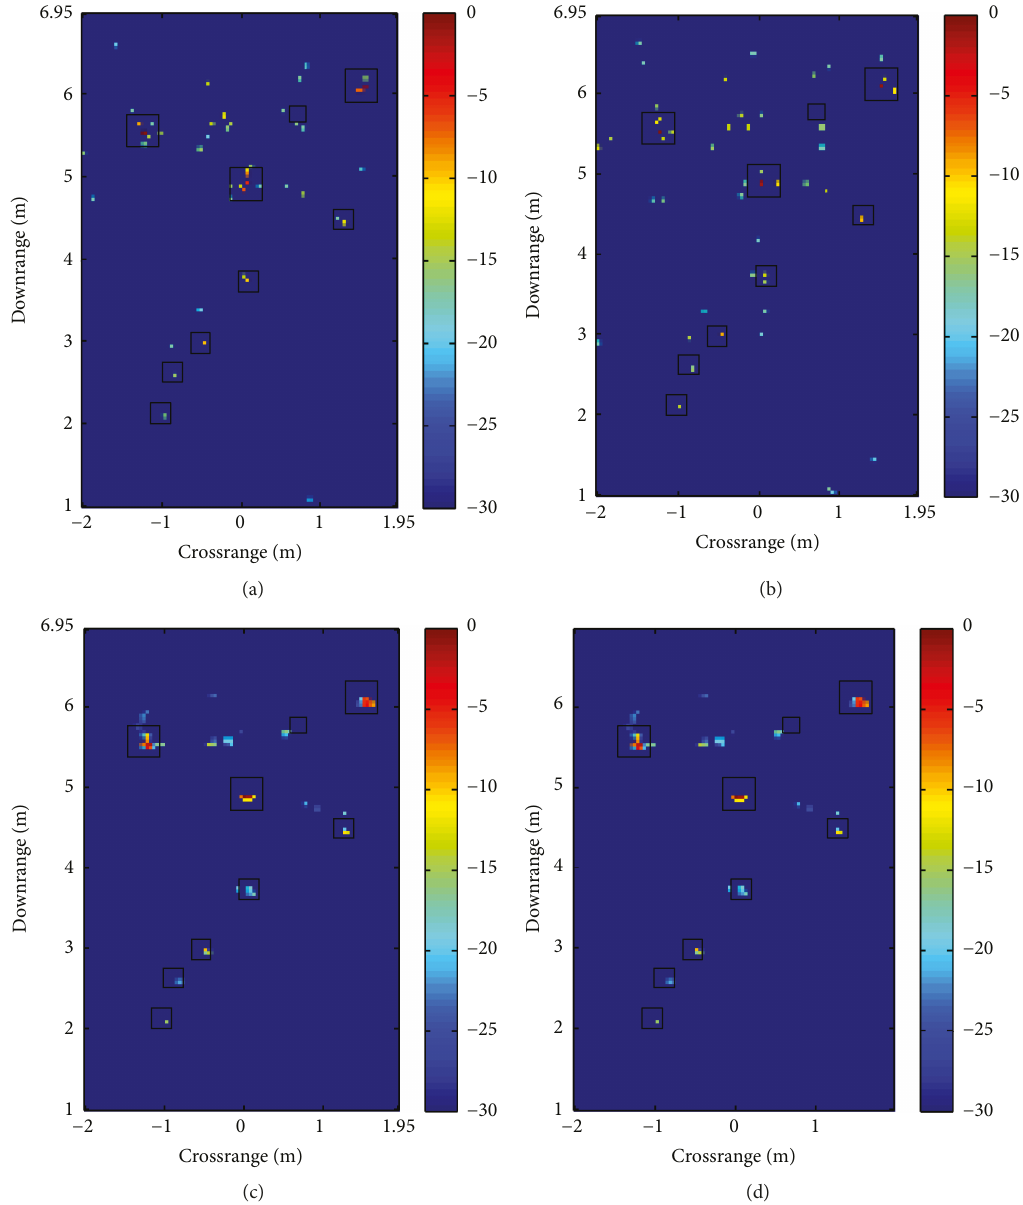
Figure 3: The imaging results of four di ff erent algorithms. (a) MT-BCS. (b) LAHMP. (c) The traditional SPGL1. (d) The proposed NUFFT- based